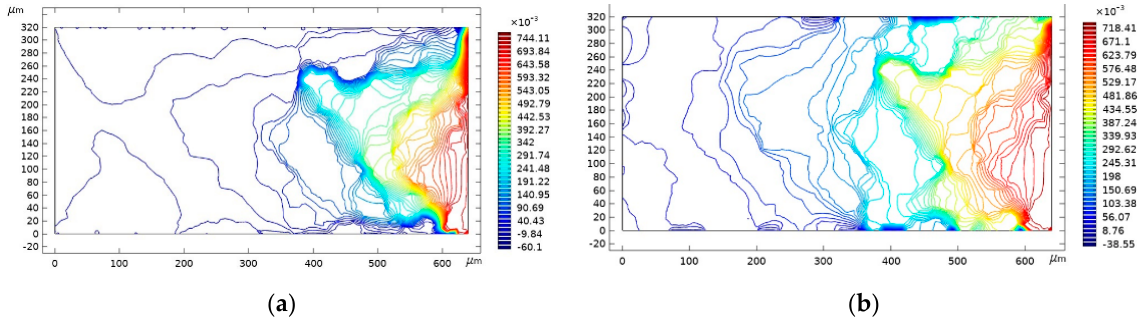
Figure 12. The pressure calculated by the Brinkman equations. ( a ) µ = 10 − 3 ; ( b ) µ = 10 6